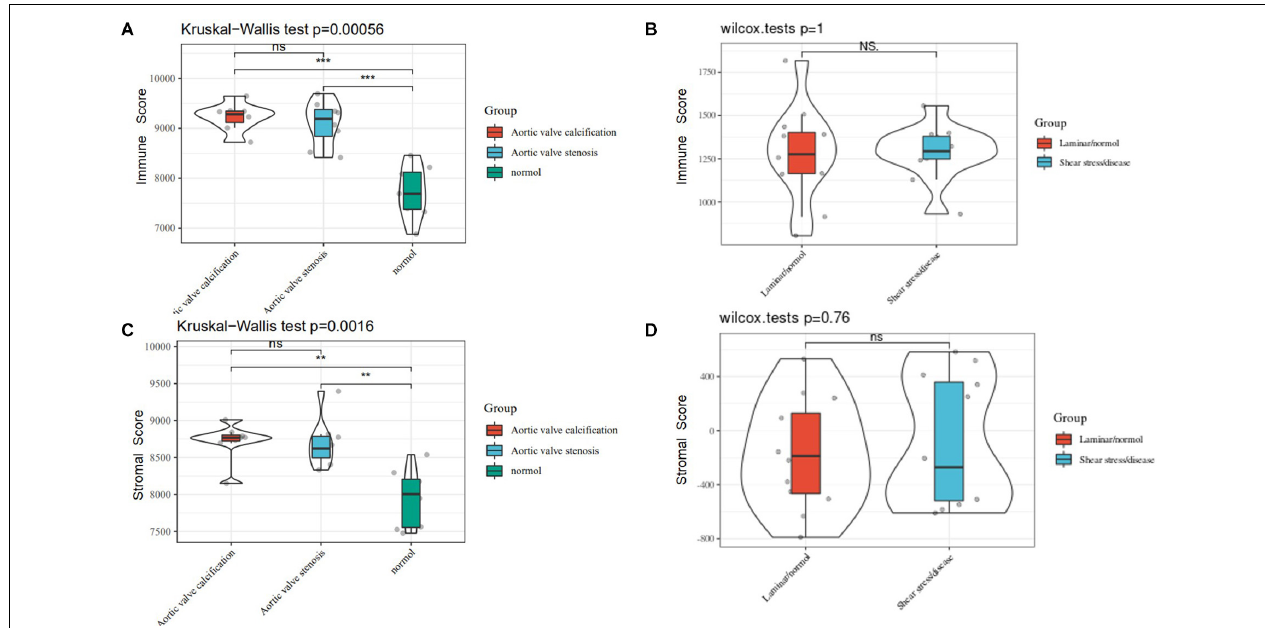
FIGURE 6 | (A) The immune score of the normal, calcification, and stenosis groups of GSE83453. (B) The immune scores of the laminar flow group and the shear stress group in GSE26953. (C) The stromal scores of the normal, calcification, and stenosis groups. (D) The stromal scores of the laminar flow group and the shear stress group.